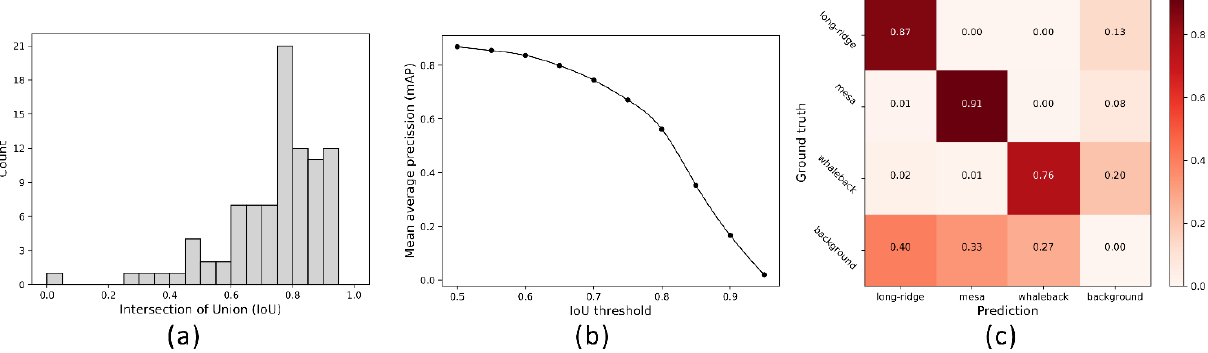
Figure 4. Metrics used to evaluate the accuracy of the Mask R-CNN model to detect yardangs on test dataset. (a) Histogram of IoU values between predicted masks and ground truths. (b) mAP over IoU thresholds of 0.50-0.95. (c) Normalized confusion matrix of classification results of three types of yardangs and the background.